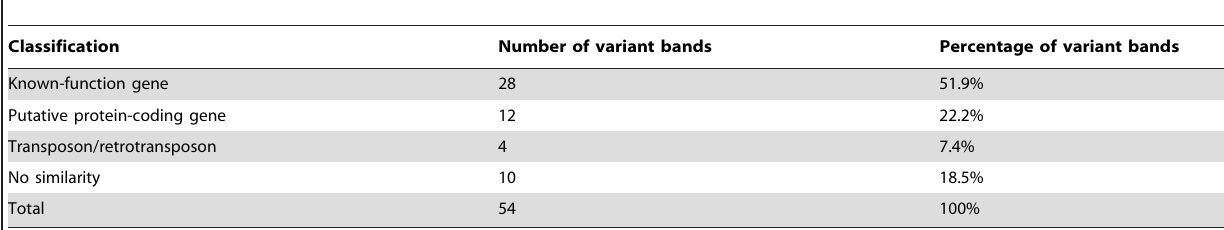
Table 1. Functional classification of cloned MSAP bands showing alterations in DNA methylation pattern in grafted plants based on